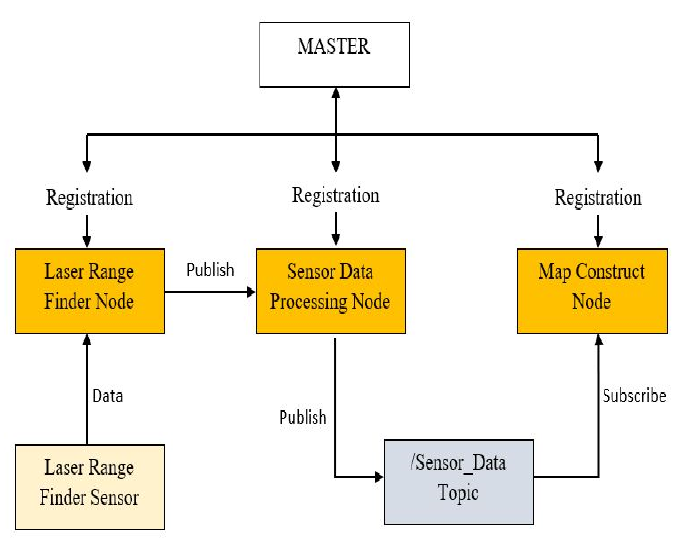
Figure 3. ROS Master and ROS Node with published and subscribed topics.